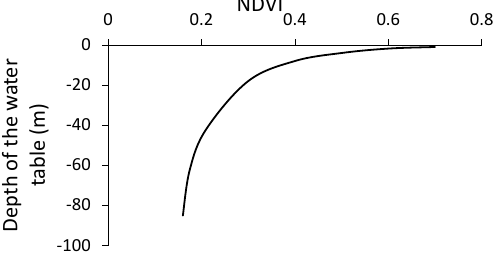
Figure 1. The relationship between NDVI and depth to the water table for the Hailiutu River catchment in northern China. Redrawn from Lv et al.